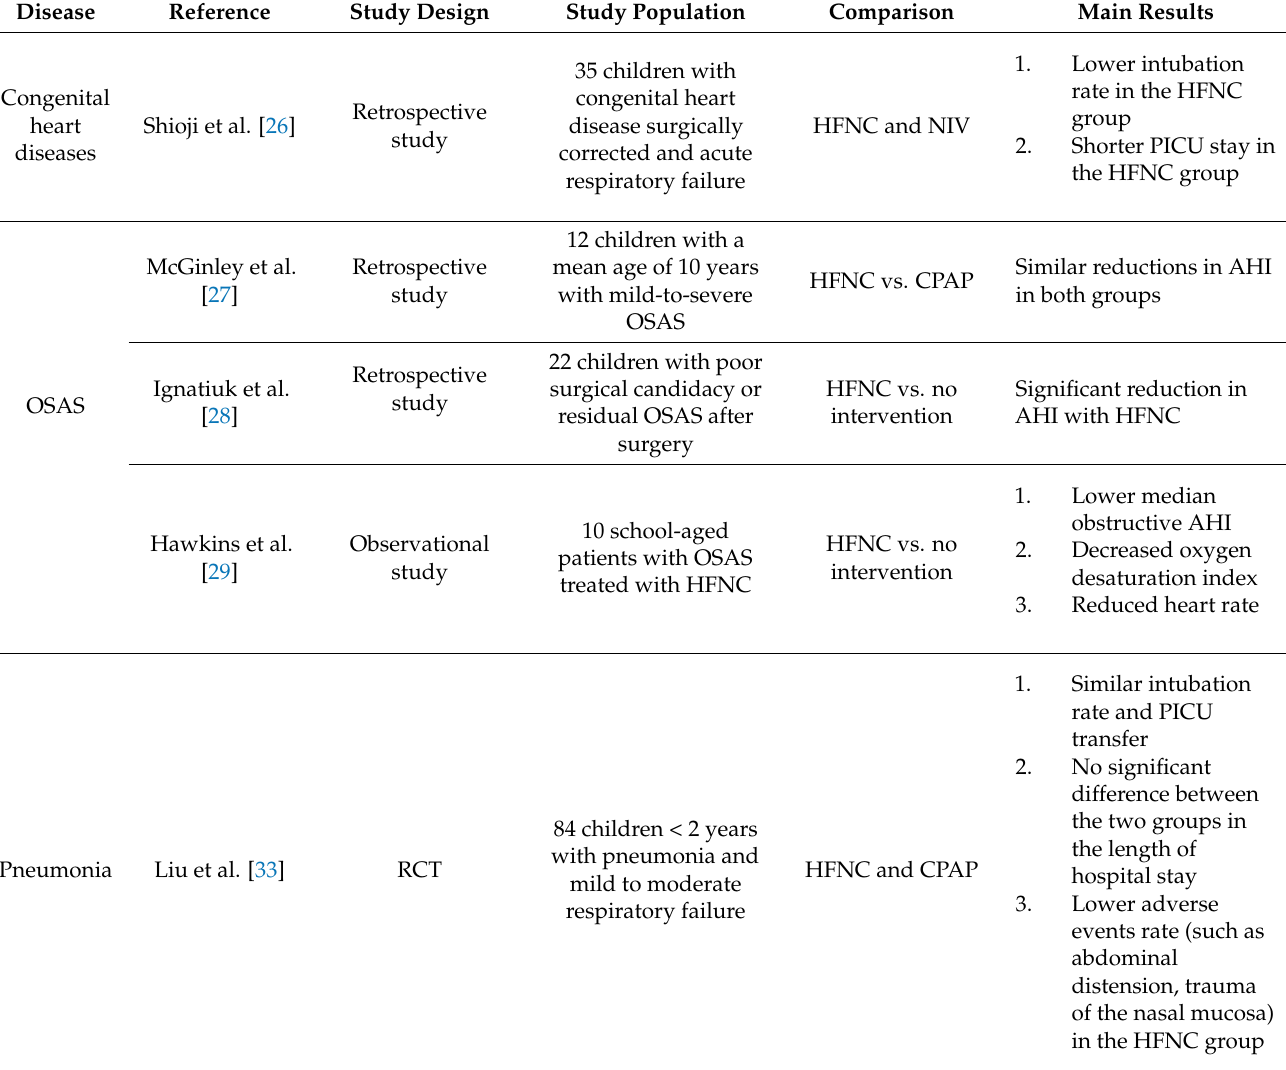
Table 3. Other clinical indications for HFNC in pediatric